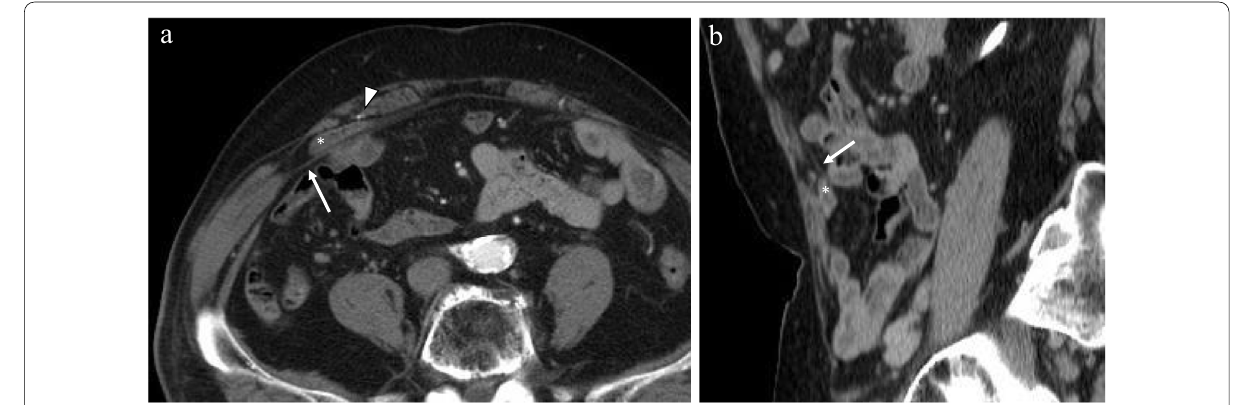
Fig. 2 Abdominal contrast-enhanced computed tomography, axial plane ( a ) and sagittal plane ( b ). Protrusion of the small bowel (asterisk) is evident between the rectus muscle and the posterior rectus sheath (arrow). The arrowhead indicates the right inferior epigastric